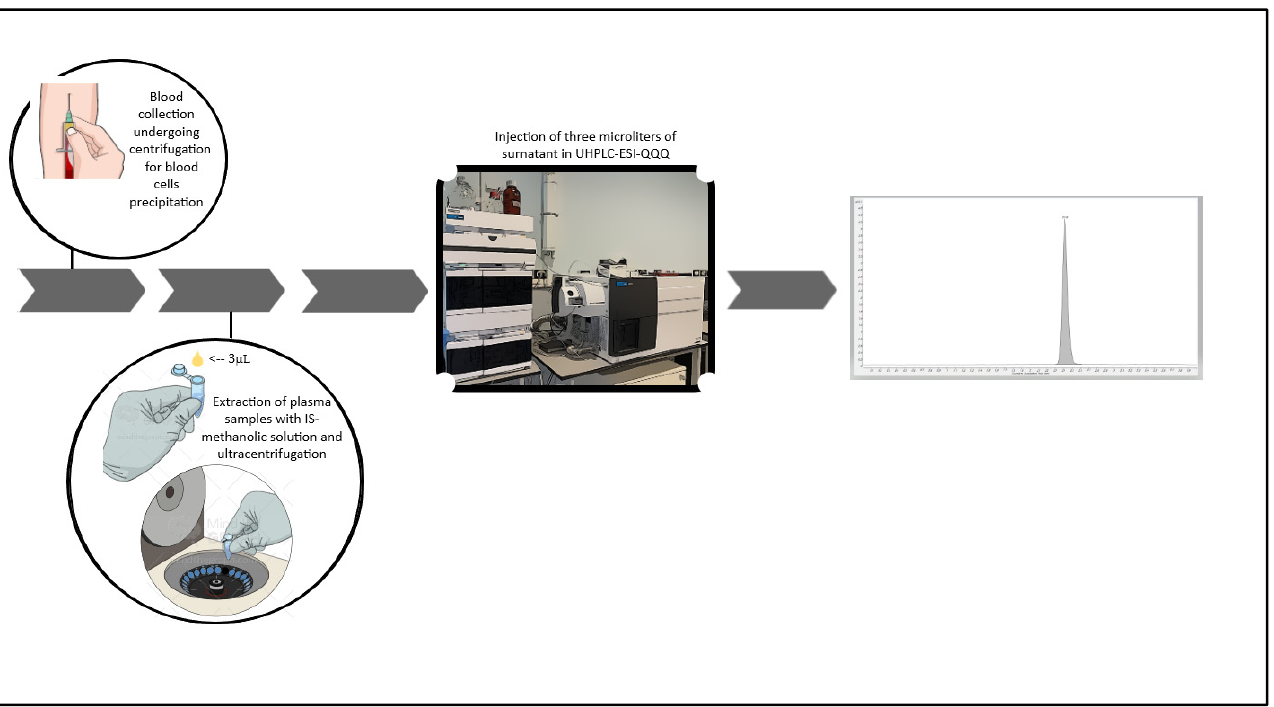
Figure 2. Images above describes the working flow of the developed method.